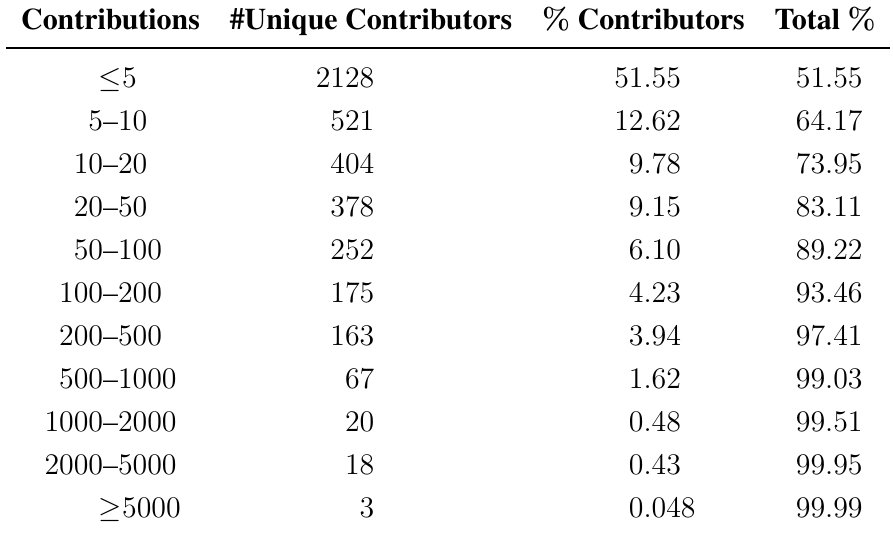
Table 2. The number of edits or contributions performed by all of the OSM contributors in our case-study area.